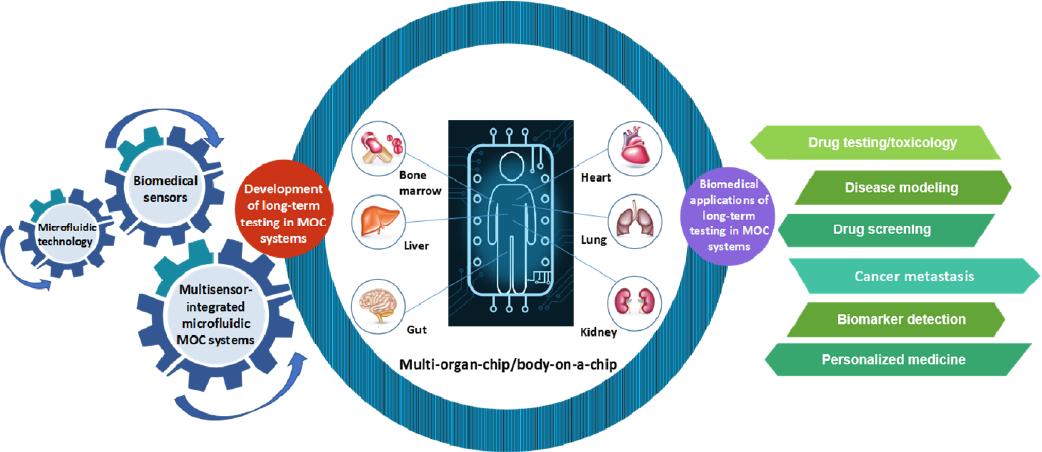
Figure 1. Schematic illustration highlighting the development of long-term testing in MOC systems, and the various proposed and potential biomedical applications of long-term testing in MOC